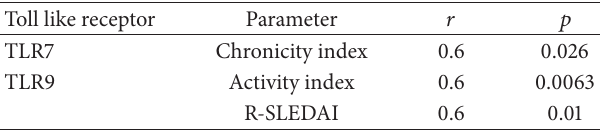
Table 4: Correlation between kidney TLRs expressions and clinico- pathological parameters of lupus nephritis